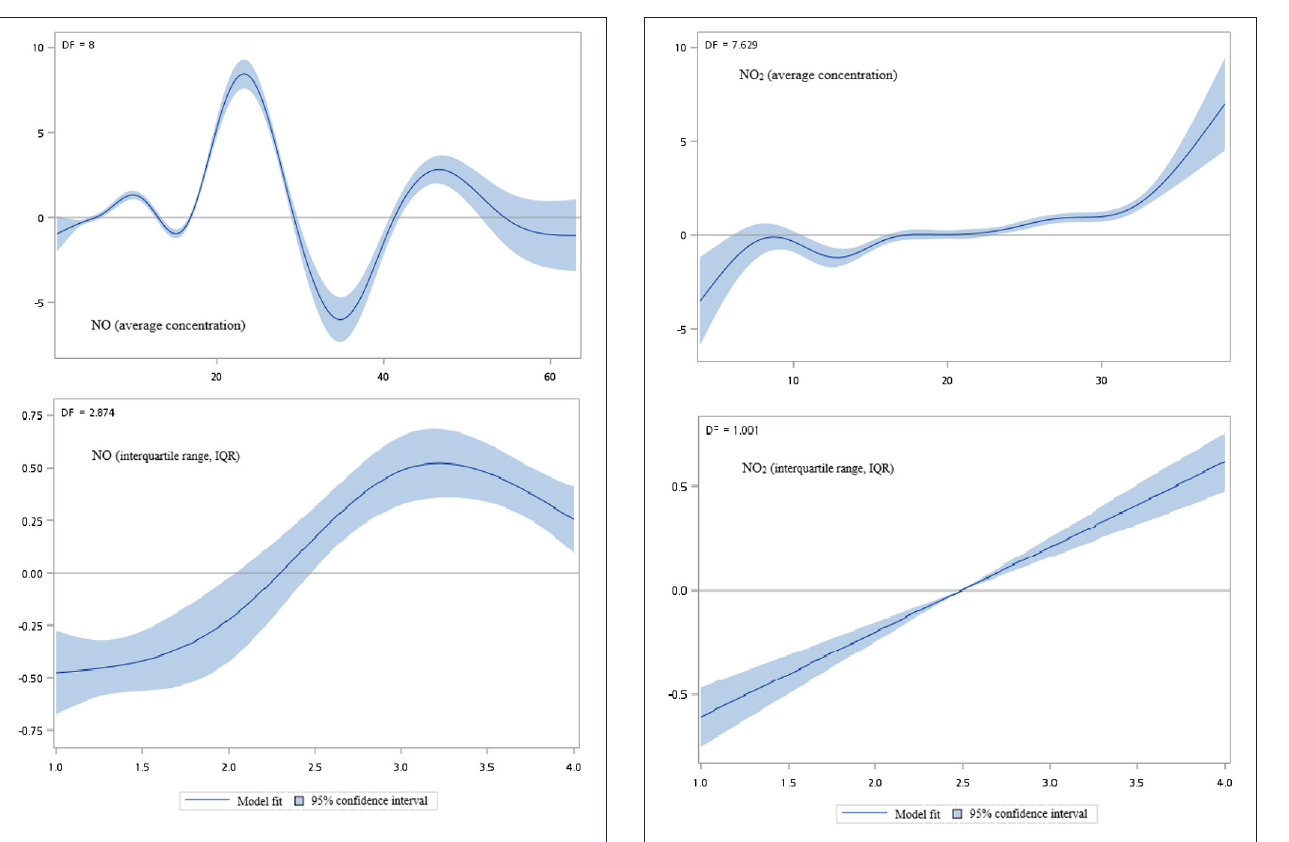
FIGURE 4 | Generalized additive model plot for air pollutions (NO 2